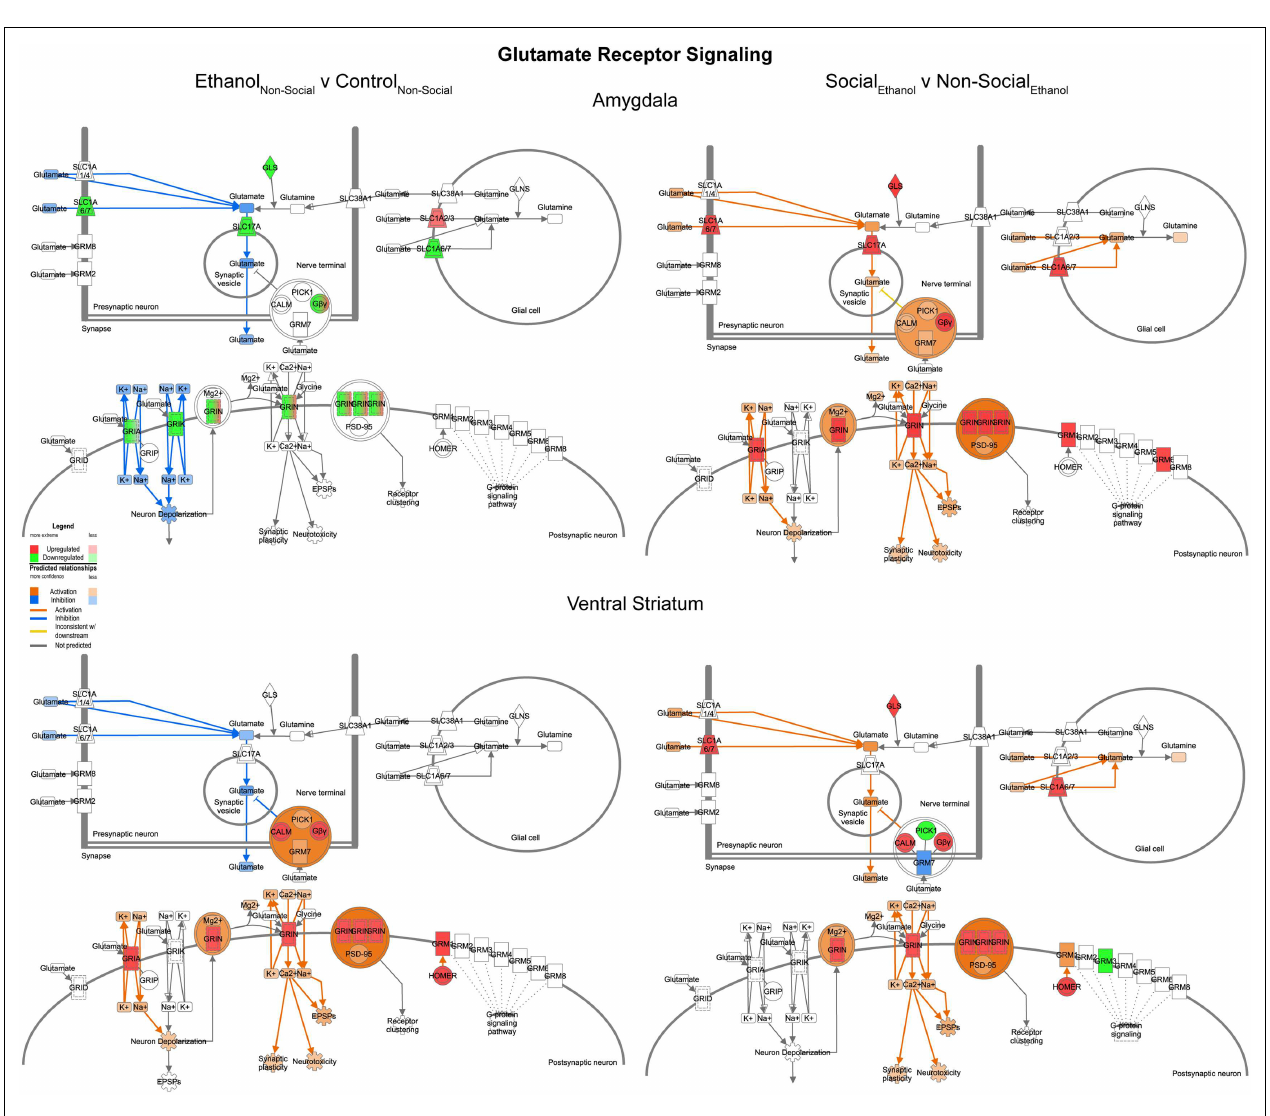
FIGURE 8 | Ethanol and social enrichment effects on glutamate receptor signaling . Conventions same as Figure 3 . Note that this network tended to show differential changes due to prenatal ethanol exposure in the two brain areas (left), but somewhat more consistent changes following social enrichment